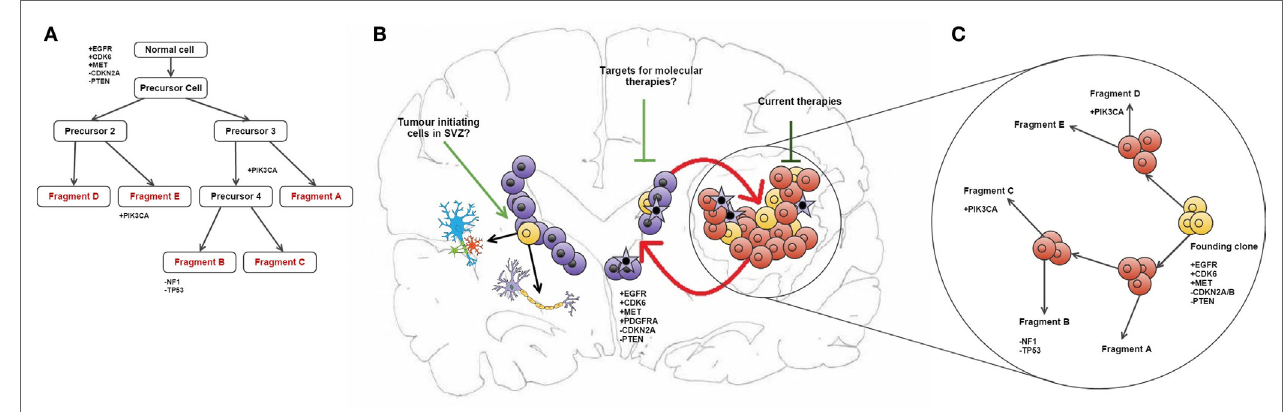
FiGURe 1 | intratumour heterogeneity in the evolution of GB . (A) Phylogenetic reconstruction of a GB case based on copy number alterations. (B) It has been hypothesized that TICs reside in the SEZ and can contribute to tumor maintenance (19). These cells (shown in purple) may be potential new targets for molecular therapies in GB. Also shown is the maintenance of the tumor bulk by cells in the SEZ containing the same mutations as described in the phylogenetic tree, and how current therapies target the tumor bulk (shown in red). (C) combines (A,B) to give an overview of tumor evolution in this case across time and in physical location. The case described in all parts of this diagram and all corresponding genetic information was obtained from Sottoriva et al. (10). (B) is adapted from the review by Goffart et al. (20).